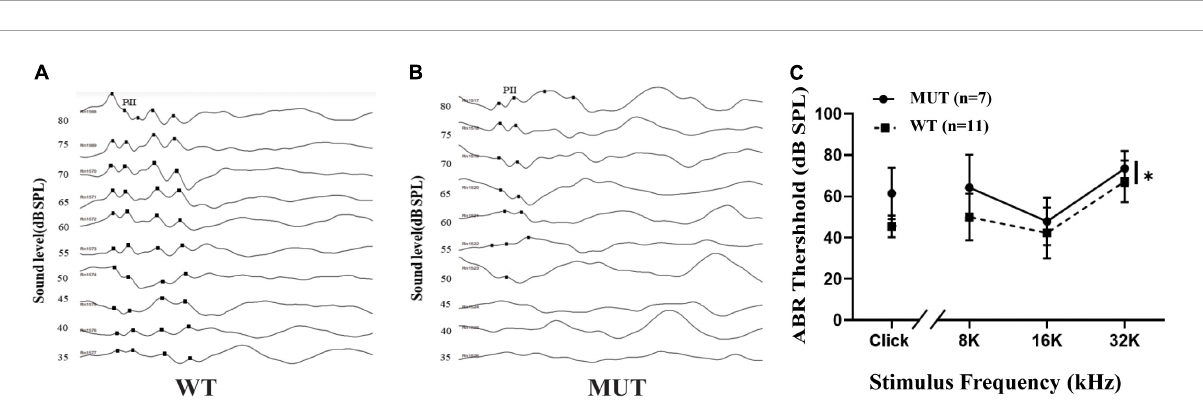
FIGURE2 Timm8a1 I 23 fs 49 X / I 23 fs 49 X MUT mice had hearing impairment at an early age. (A) Representative auditory brainstem responses (ABRs) (to 16 kHz pure-tone stimuli) of wild-type (WT) mice at the age of 4–5 weeks. Five positive peaks of the waveforms are shown, and wave two was labeled as PII. (B) Representative ABRs (to 16 kHz pure-tone stimuli) of MUT mice at the age of 4–5 weeks. (C) Thresholds for ABRs evoked by clicks and 8–32 kHz pure-tone pips are shown for the WT mice and the MUT mice, suggesting that the MUT mice had elevated threshold of ABRs (WT, n = 11; MUT, n = 7, ∗ p < 0.05). Error bars represent mean ±